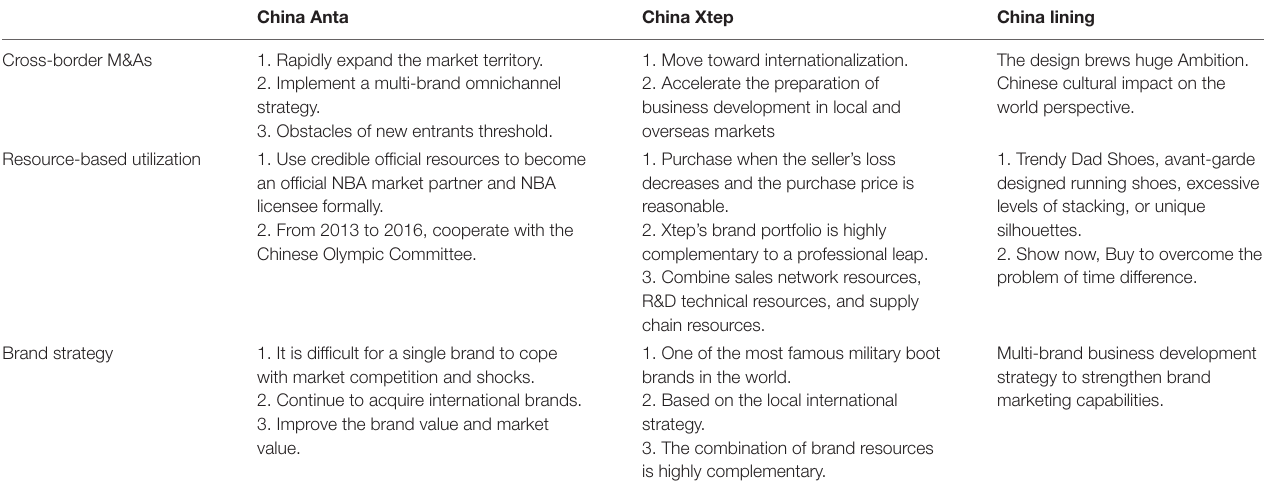
TABLE 2 | The corporate brand overseas